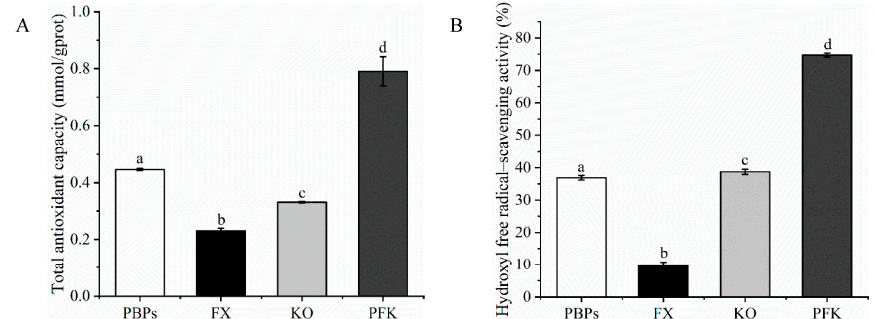
Figure 1. Antioxidant activities in vitro. ( A ) The total antioxidant activity. ( B ) Hydroxyl-free radical scavenging. Different superscript letters (a, b, c, d) within the same biochemical parameter show significant difference ( p < 0.05).